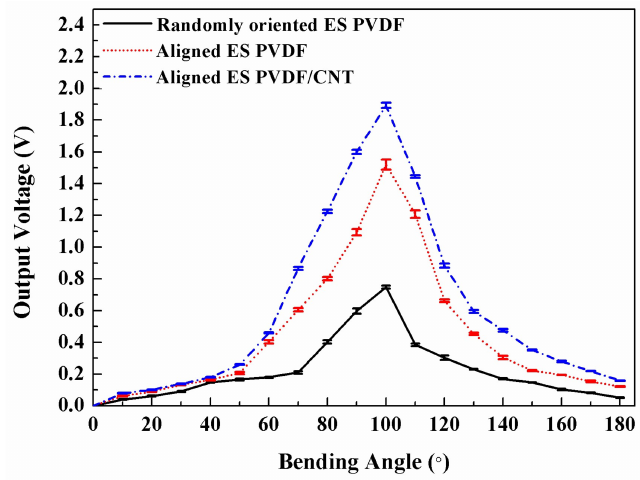
Figure 8. Bending angle vs. output voltage of the piezoelectric PVDF units.